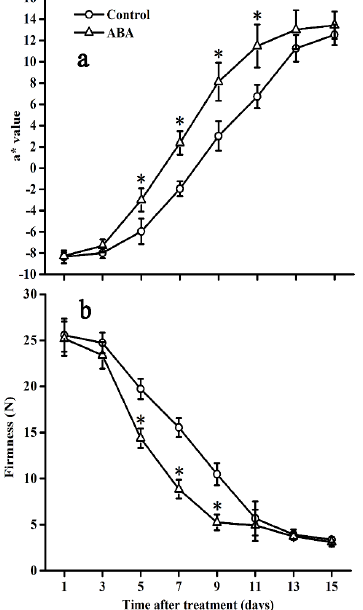
Figure 1. Effect of abscisic acid (ABA) on colour ( a ) and firmness ( b ) in the tomato during storage at 20 °C. Vertical bars represent the standard deviation (SD, n = 3). Asterisks (*) represent significant differences ( p < 0.05) between the ABA and control treatments.